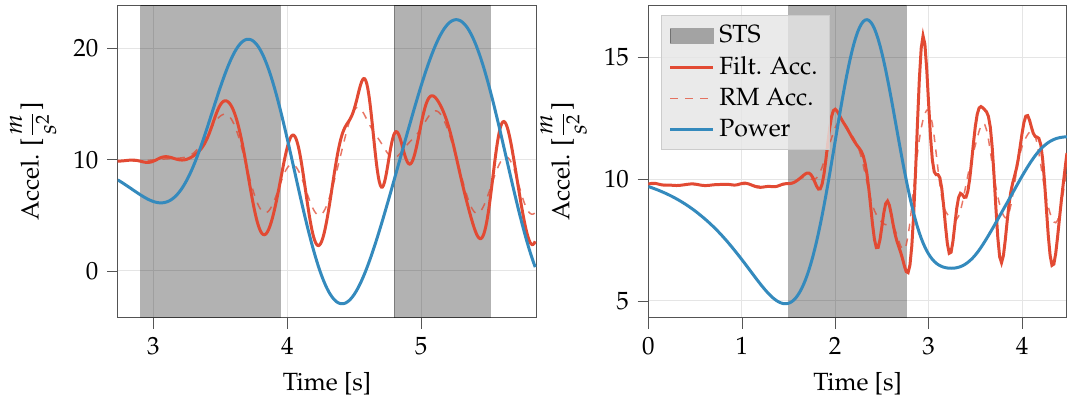
Figure 1. Example acceleration and processed signals showing the automatic segmentation of STS transfers by the proposed algorithm. ( Left ) Example in-lab signal from the 5x STS, with STS transfers detected with the displacement method. ( Right ) Example at-home signal with STS transfer detected with the displacement + stillness method. STS is sit-to-stand, Filt. Acc. is the filtered acceleration, RM is rolling mean, and Power is the Continuous Wavelet Transform power. Note: Power is not to